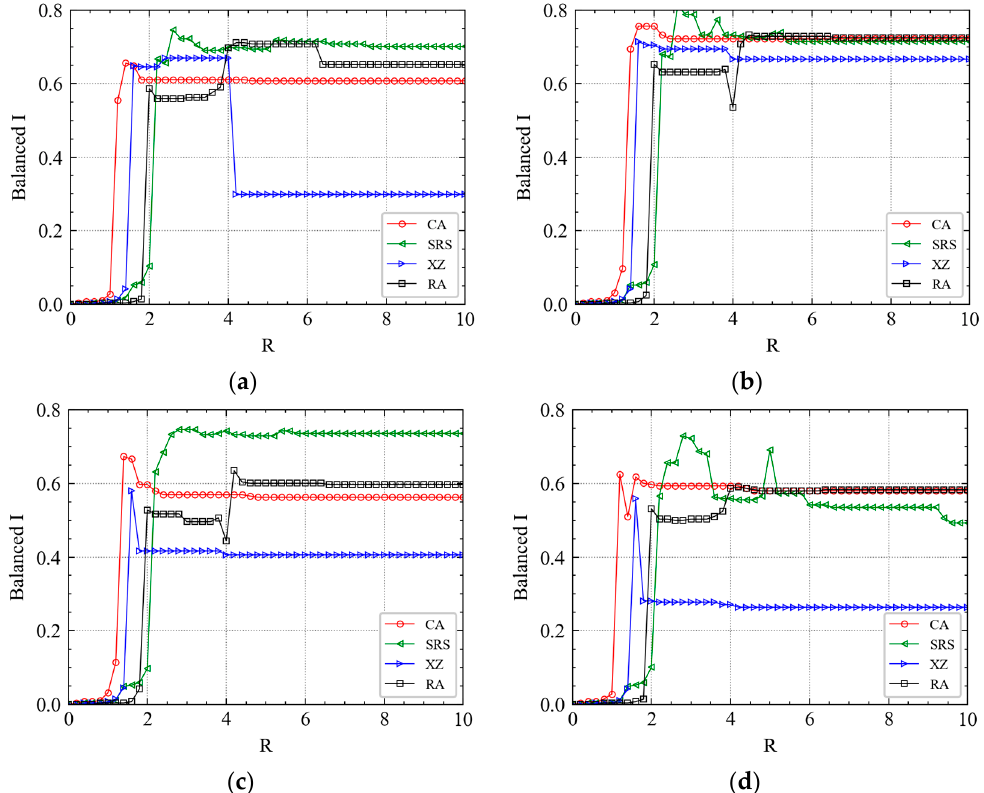
Figure 5. With the increase of R, the cumulative failure proportion of the system will get a balanced value under different attacks. ( a ) The evening peak of April’s first Wednesday. ( b ) The evening peak of April’s second Wednesday. ( c ) The evening peak of April’s third Wednesday. ( d ) The evening peak of April’s fourth Wednesday. Table 3. The critical perturbation threshold at different times.